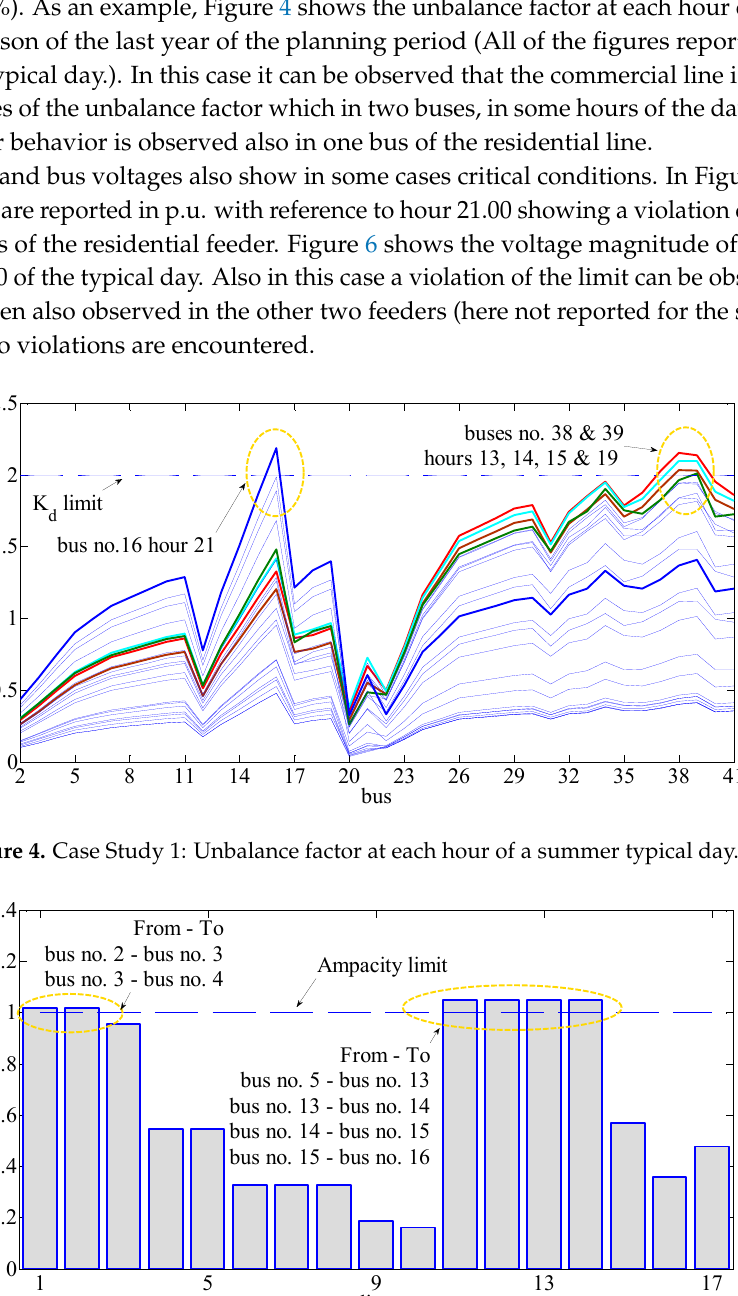
Figure 6. Case Study 1: Voltage magnitude of the residential feeder at hour 21.00 of the typical day. 4.2. Case Study 2 In this case the support of the distributed resources is considered and DESSs are allocated by means of a GA applied over the set constituted by all network’s buses. A maximum value of 440 kWh was imposed to the capacity that could be allocated in the whole network and a maximum value of 12 kWh was imposed to the capacity that could be placed at the single bus. Both single-phase and